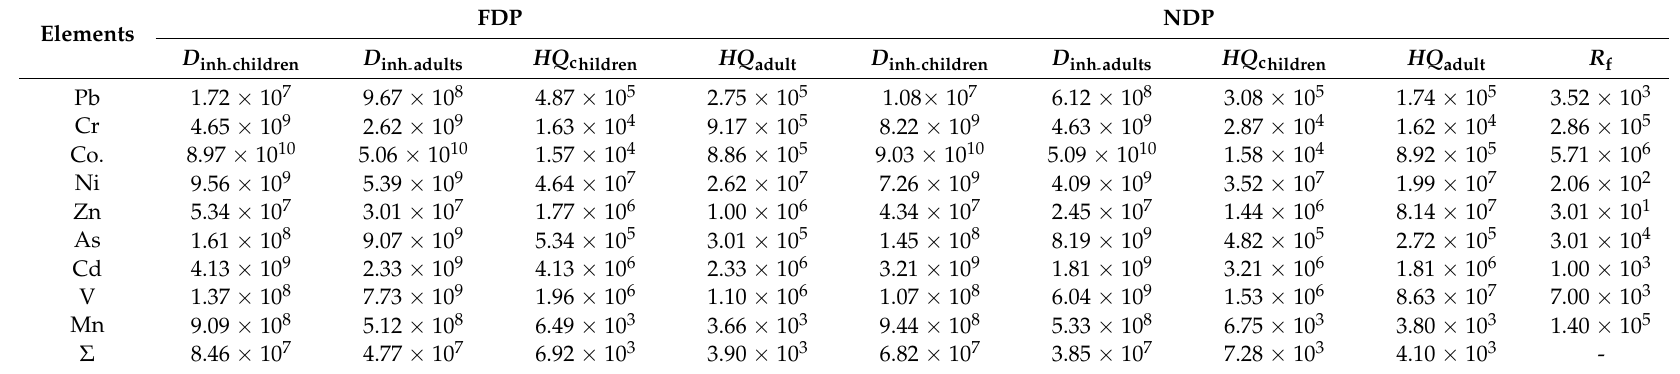
Table 3. Hazard quotients, hazard indexes, and cancer risks for selected metals present in PM 10 in Bangkok.